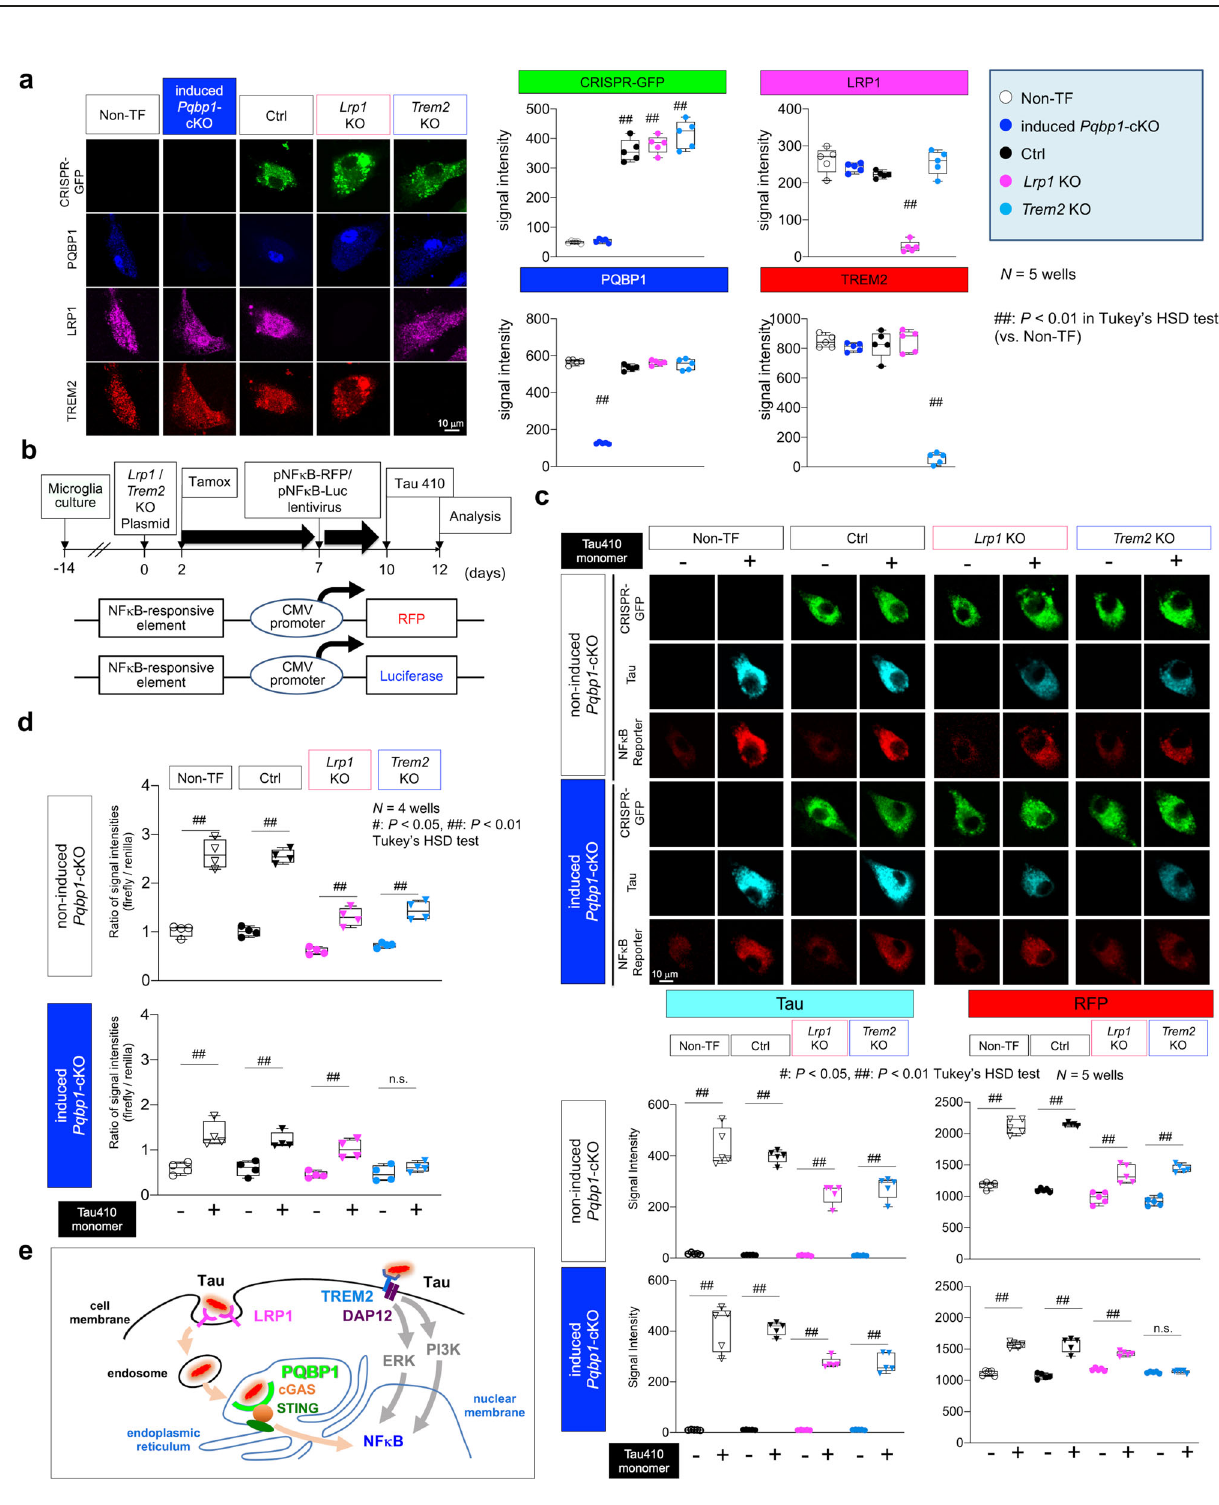
Fig. 7 PQBP1-Tau interaction is essential for in vivo activation of microglia. a Protocol of injection of Tau 410 or Tau 410 PQBP1-binding mutant monomers (0.5 μ g/ μ l, 4.0 μ l/injection, 4.0 μ g/mouse) or equivalent PBS to bilateral entorhinal cortices of non-induced or tamoxifen-induced Pqbp1 -cKO mice. Five groups were used for analyses. b , c Immunohistochemistry of Iba1-positive microglia with PQBP1 + tau, cGAS + tau, NF κ B-p65 + tau colocalization in injected area of non-induced Pqbp1 -cKO, and tamoxifen-induced Pqbp1 -cKO. Quantitative analyses of PQBP1-Tau colocalized microglia, cGAS-tau colocalized microglia, and activated microglia (nuclear NF κ B-positive) among Tau-incorporating microglia are shown in the graphs on the right. N = 10 (visual fi elds, from 3 mice). ## P < 0.01 in Tukey ’ s HSD test. d , e RT-qPCR of Tnf and Isg54 induction by Tau 410 and the PQBP1-binding mutants with entorhinal cortex tissues prepared from non-induced or tamoxifen-induced Pqbp1 -cKO mice. N = 3. ## P < 0.01, n.s. P > 0.05 in Tukey ’ s HSD test (two- sided, multiple comparison). Box plots show the median, quartiles, and whiskers that represent data outside the 25th to 75th percentile